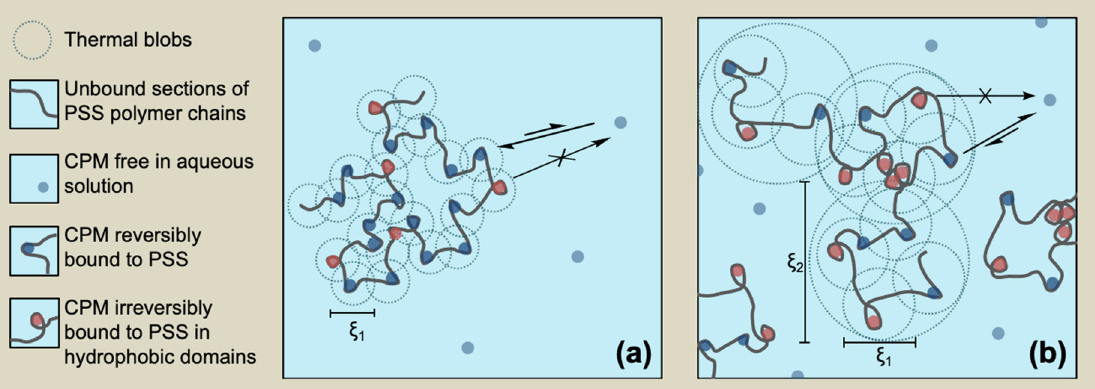
Figure 9. Molecular diagram of the PSS n /CPM n/2 system at different concentrations where ξ 1 and ξ 2 , as well as the irreversibly bound fraction of CPM confined in folds and bundles of the polyelectrolyte chain increase at an increasing system concentration: ( a ) dilute regime; ( b ) semidilute regime.